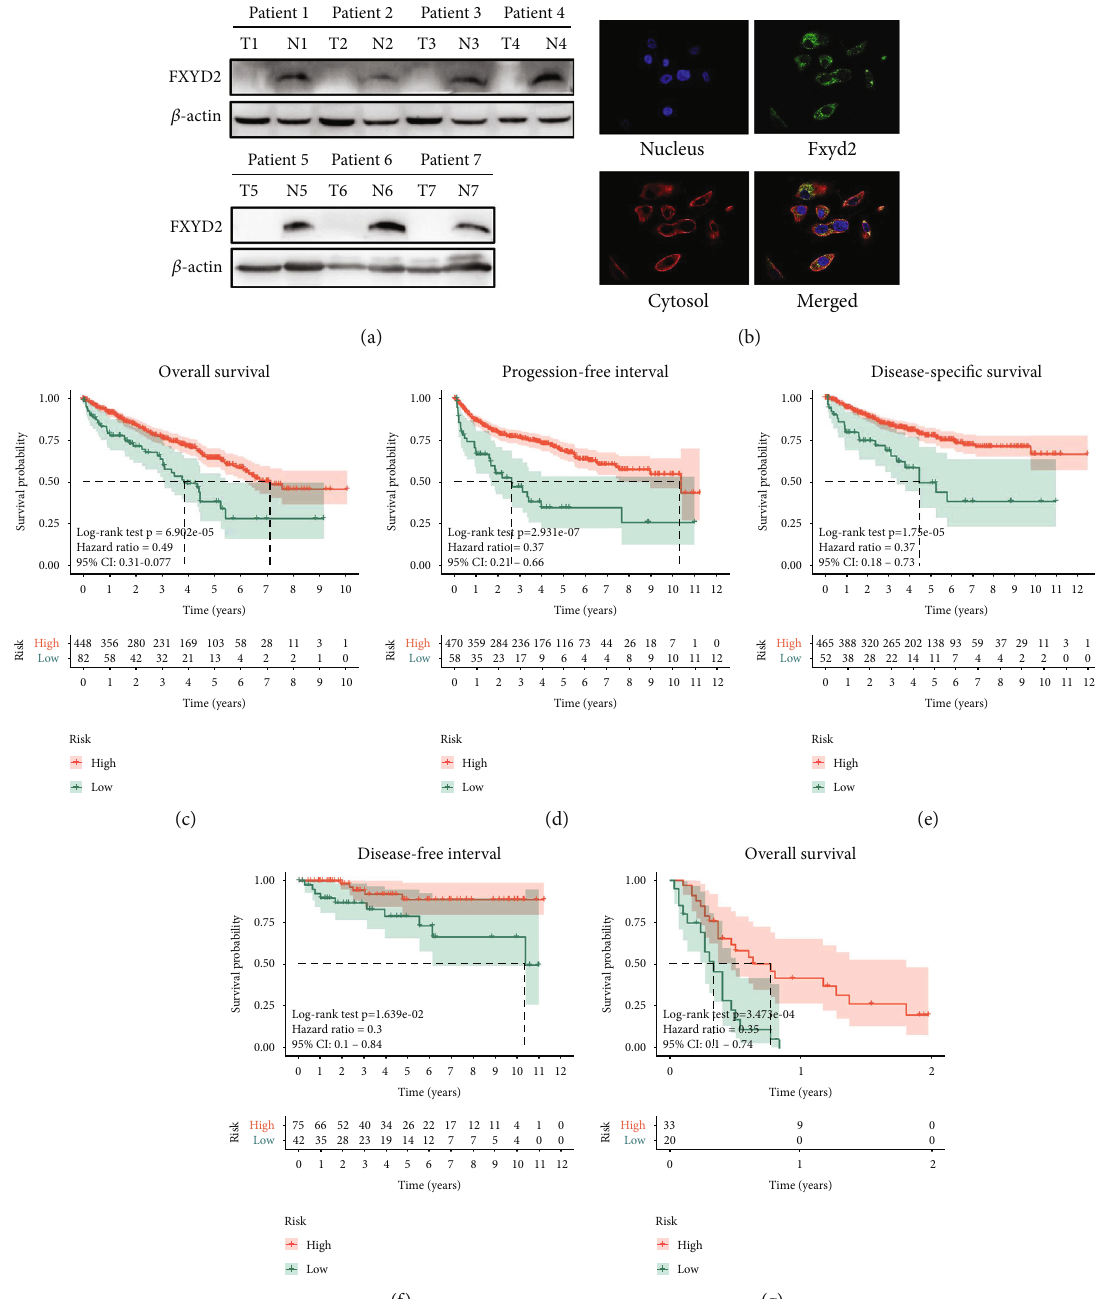
Figure 2: Western blot, subcellular location, and Kaplan-Meier survival analysis of FXYD2 in ccRCC. (a) Western blot analysis of FXYD2 from clinical samples showed downregulated expression in ccRCC tissue. (b) Subcellular location from The Human Protein Atlas showed FXYD2 proteins locate in cytoplasm. (c – f) CcRCC patients with low FXYD2 expression correlated with short-term overall survival, progression-free survival, disease-speci fi c survival, and disease-free survival, respectively, in the TCGA cohort. (g) CcRCC patients with low FXYD2 expression correlated with short-term overall survival in the E-MTAB-3267